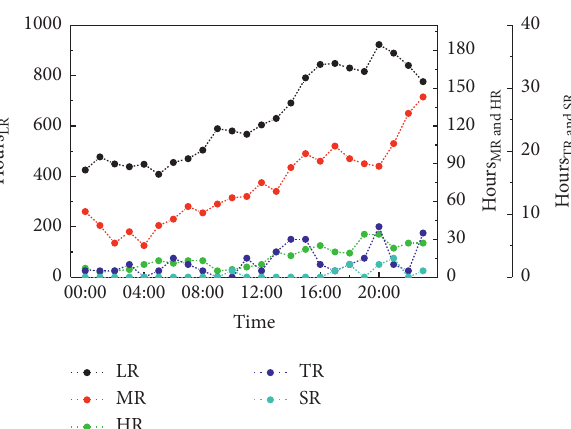
Figure 4: Diurnal variation of the occurrence of different-level precipitation during pollution weather in Hubei Province from 2015 to 2017. Table 3: Distributions of V PM2.5 and V PM10 under different C PM2.5/PM10 intervals during rainfall hours. C